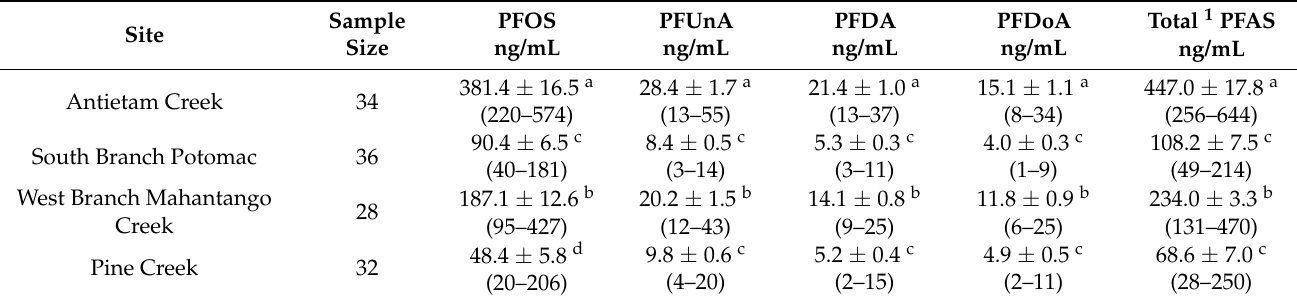
Table 3. Site comparisons of the perfluoroalkyl chemical concentrations detected in smallmouth bass. Presented as mean ± standard error with minimum and maximum below in